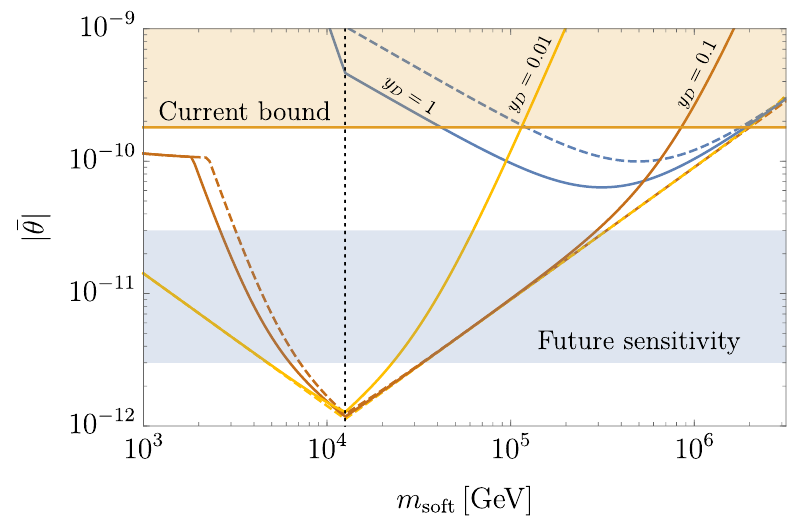
(cid:12) ¯ θ (cid:12) Figure 6 . The lower bound on (cid:12) (cid:12) , which is consistent with the baryon asymmetry, gravitino DM, and Lyman- α constraint. We take y D = 0 . 01 , 0 . 1 , and 1 for the yellow, brown and blue lines, respectively. The solid (dashed) lines represent the case of N = 3 ( N = 4 ). The red-shaded region is excluded from the current constraint on ¯ θ [151]. The blue shaded region represents the typical sensitivity of future experiments